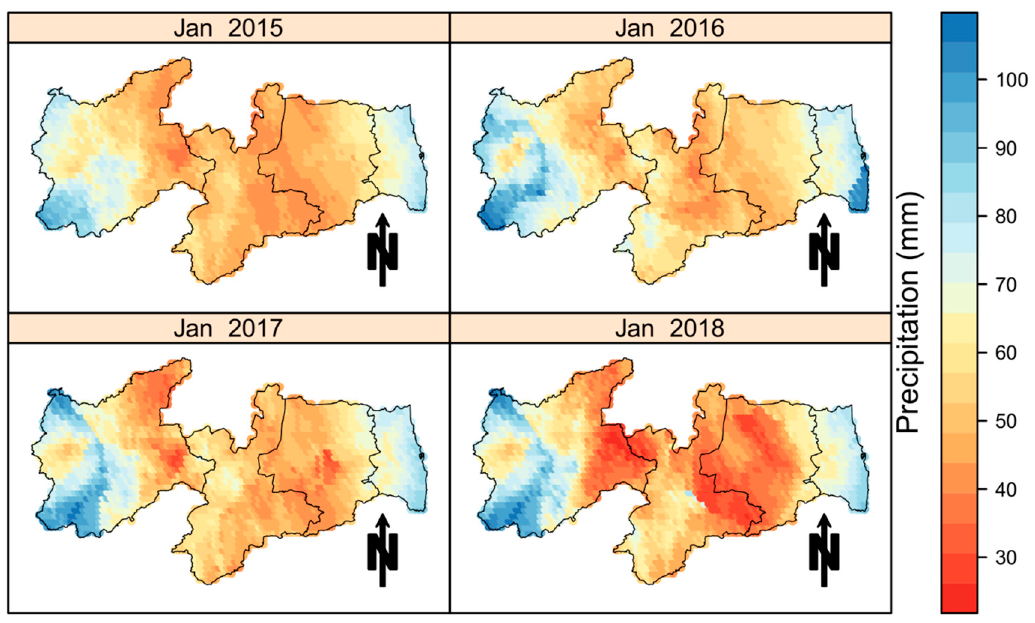
Figure 8. Prediction maps of precipitation in January 2015–2018.